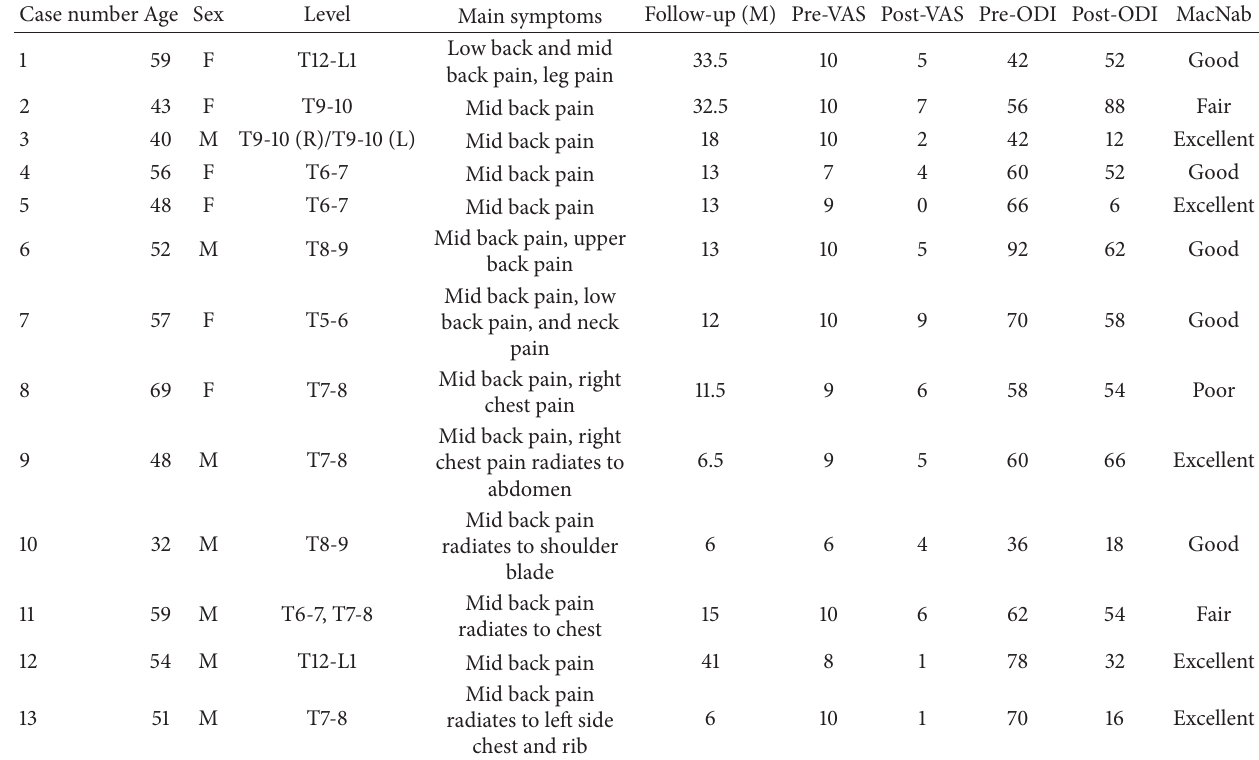
Table 1: Patient baseline characteristics and clinical